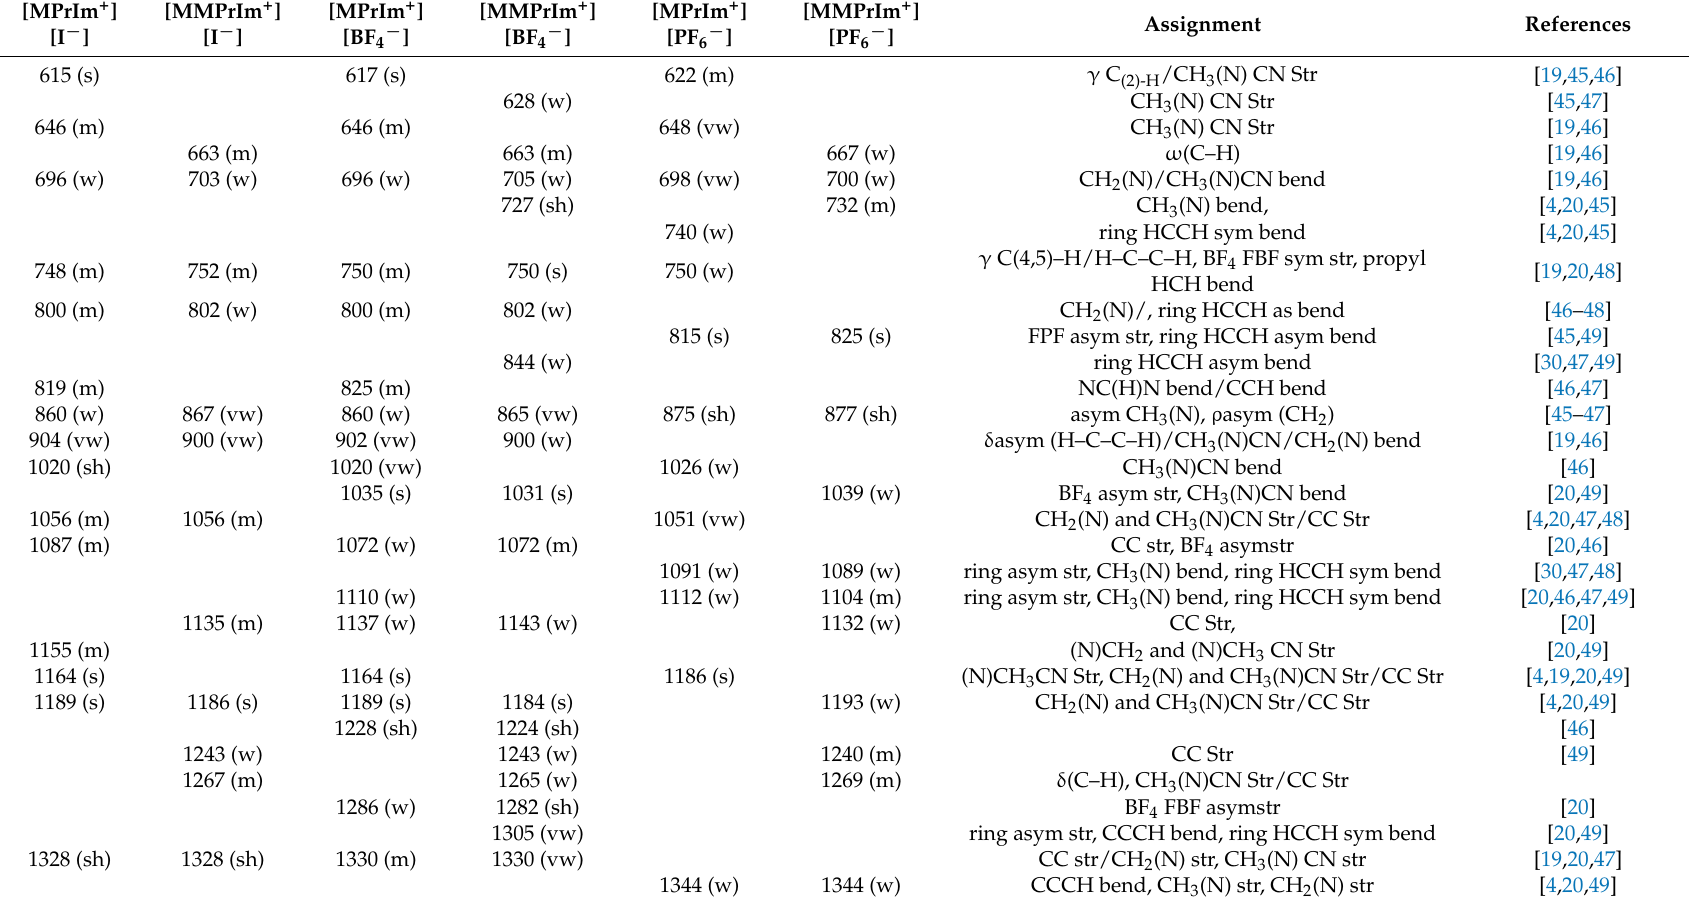
Table A1. Observed FTIR/ATR bands and their tentative assignment of [1-MPrIM+][I − ], [1,2-DMPrIM+][I − ], [1-MPrIM+][BF 4 − ], [1,2-DMPrIM+][BF 4 − ], deformation, γ = out of plane deformation, ω = wagging, ρ = rocking, sym = symmetric, asym =